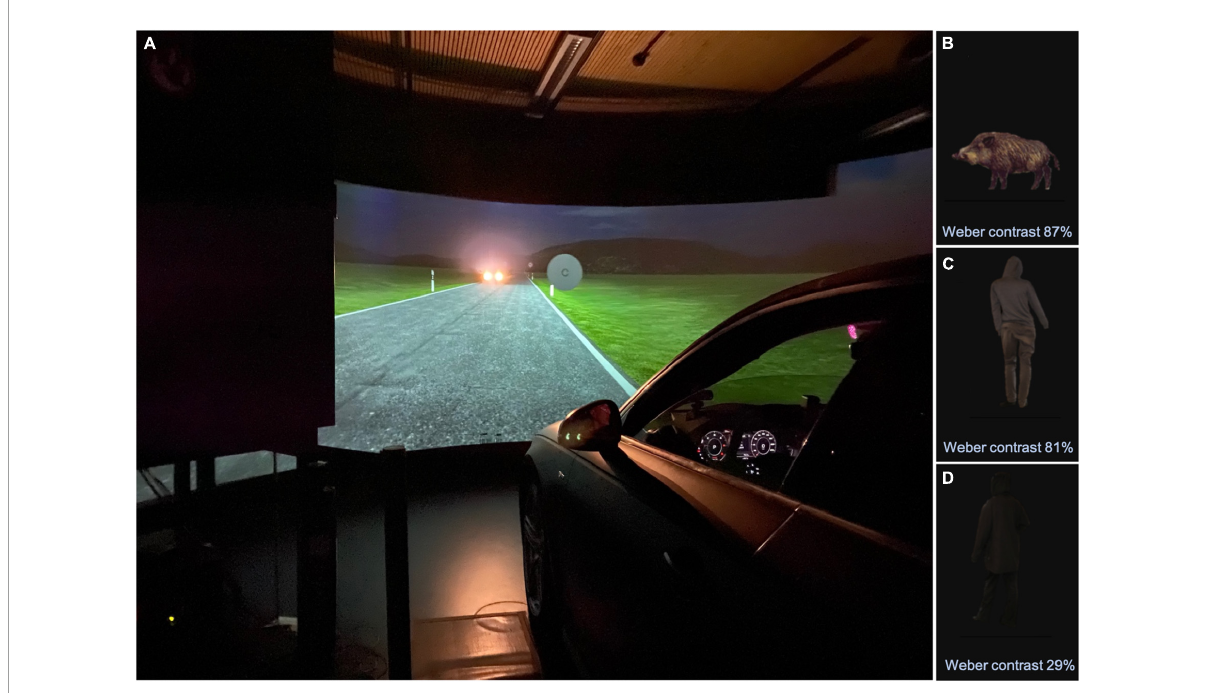
FIGURE1 (A) The fixed-base night driving simulator at the Aalen Mobility Perception and Exploration Lab (AMPEL, Competence Center “Vision Research”), located at the Innovation Centre at the University of Applied Sciences, Aalen/FRG. Visible on the right is the modified simulator vehicle (Audi A4, Audi AG, Ingolstadt/FRG), with fully digital dashboard and implemented, contactless eye and head tracking device (SmartEye, Gothenburg/SE). Visible on the left is the housing of one of the two high-performance LED planetarium projectors (Zeiss AG, Jena/FRG) - the housing provides sound insulation and cooling. In the center of the image can be seen the cylindric projection screen (radius: 3.2 m) showing a night-time driving scenario with an oncoming vehicle on a rural road with dipped headlight. These oncoming headlights were simulated by two LED arrays, moved by cable robots precisely along the trajectories required to mimic an oncoming car. WLAN signal transmission was further used precisely adjust the luminance and angle of the LED panels in a realistic fashion. As shown here, optotypes of varying visual acuity and contrast sensitivity (CS) levels, as well as obstacles of varying CS levels (not shown) were presented directly to the right of the roadside. This were presented against a uniform gray circular background. The three obstacles are shown in panels (B–D) , as follows. (B) “Wild boar” (Weber contrast 87%), (C) “man dressed in gray” (Weber contrast 81%), (D) “man dressed in black” (Weber contrast 29%).